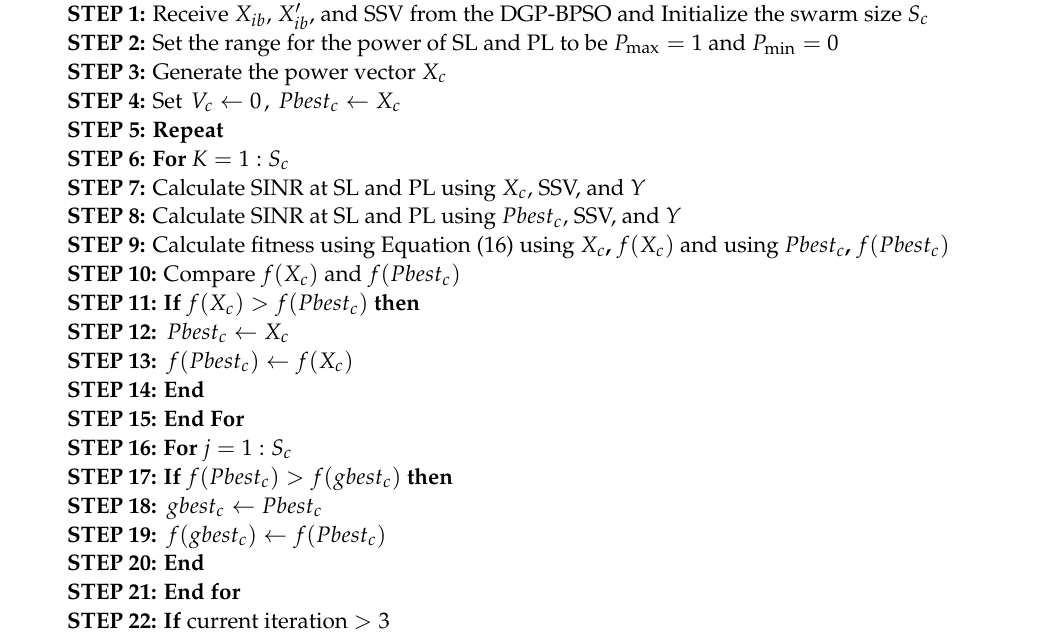
Algorithm 2 Pseudo-code for the power control with two-phase PSO